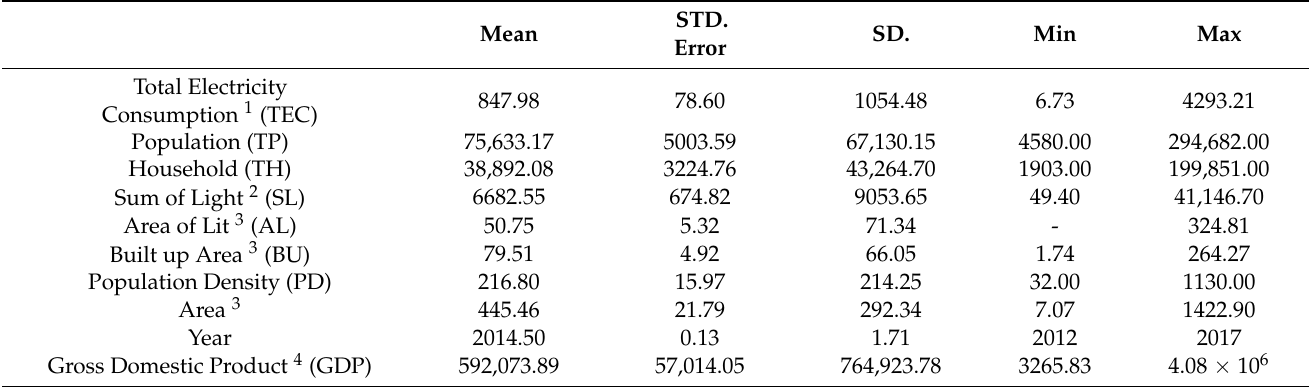
Table 1. Descriptive statistics of